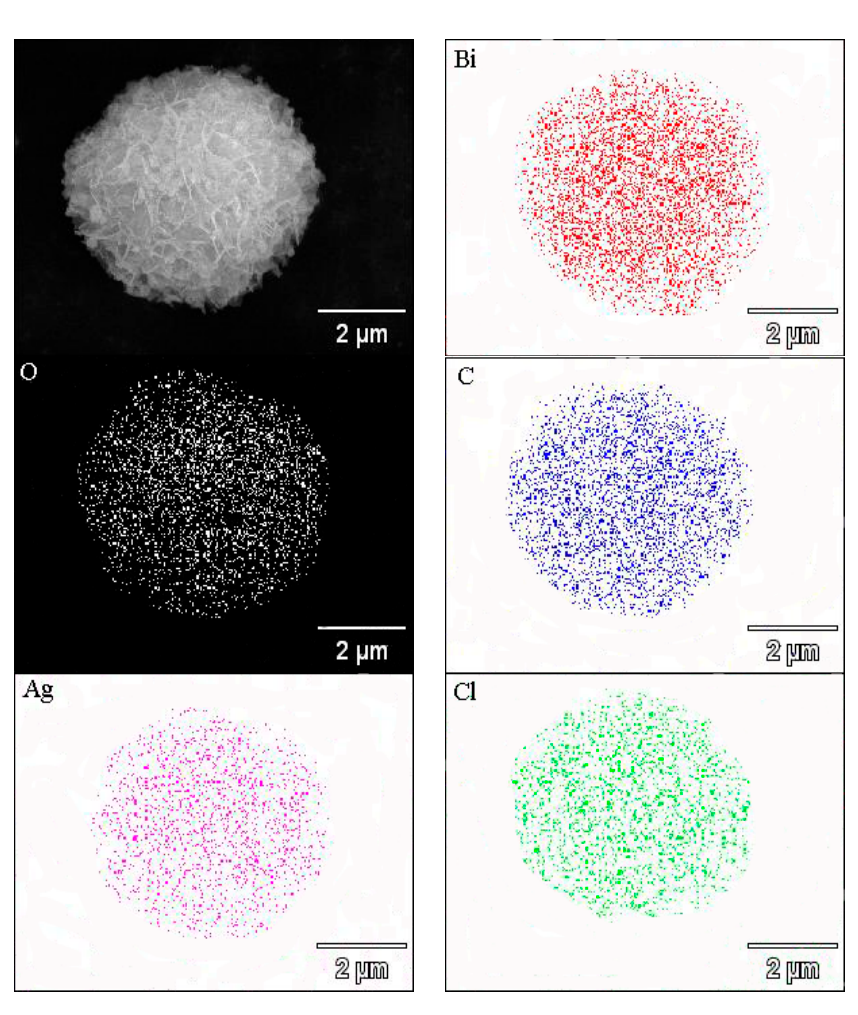
Figure 4. SEM image and EDX elemental maps of spherical structure of Ag@AgCl/Bi 2 O 2 CO 3 composite photocatalyst.